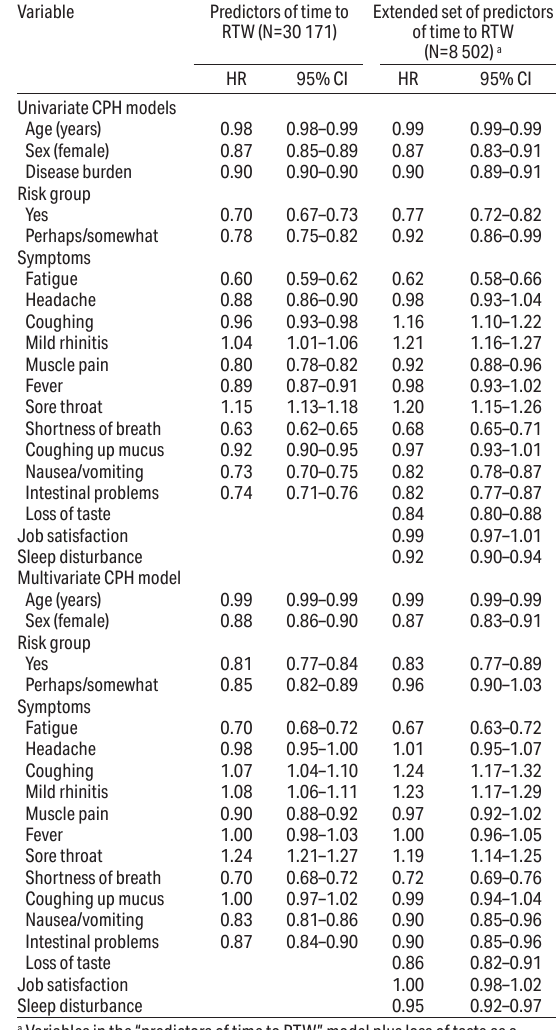
Table 3. Prediction of return to work (RTW): output of univariate and multivariate Cox proportional hazards (CPH) models. [HR=hazard ratio; CI=confidence interval]. Variable Predictors of time to Extended set of predictors RTW (N=30 171) of time to